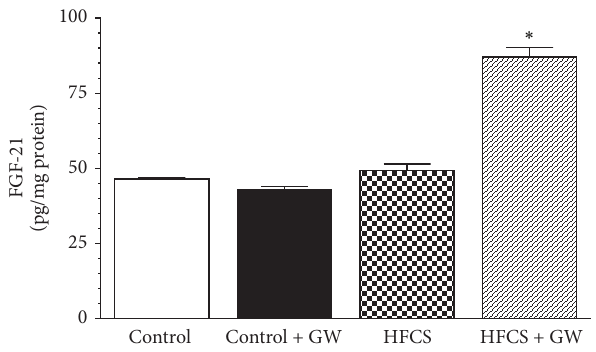
Figure 7: Fibroblast growth factor-21 (FGF-21) levels were analyzed byELISAingastrocnemiushomogenatesofmicefedwithastandard (control) or HFCS diet in the absence or presence of GW0742 (1mg/kg/day). Data are means ± SD of five animals/group. ∗ 𝑃 < 0.01 versus